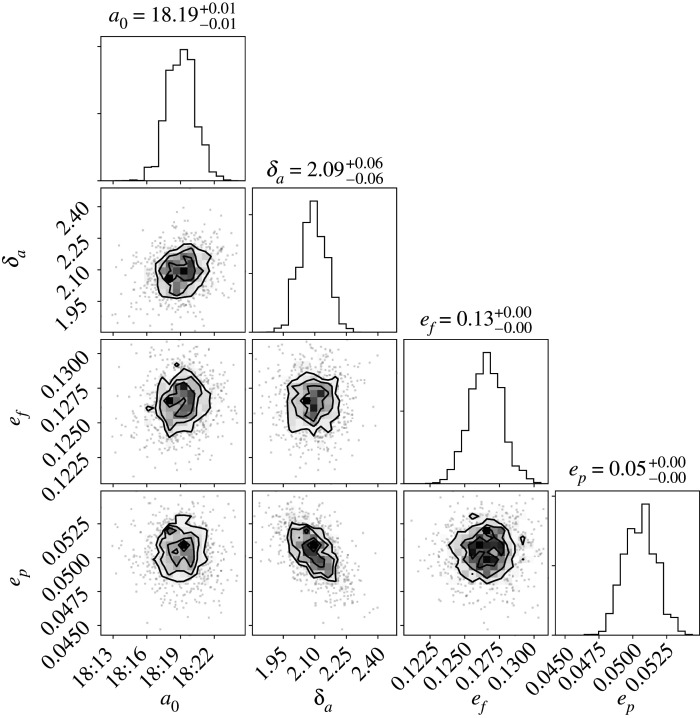
Posterior parameter distributions for the simple model of the Fomalhaut ring with a uniform range of semi-major axes. Only parameters related to the eccentric disc model are shown here. Each off-diagonal panel shows the two-dimensional distributions, with 1, 2 and 3σ contours in regions of high density, and individual dots in regions of low density. The diagonal panels show the one-dimensional distributions.